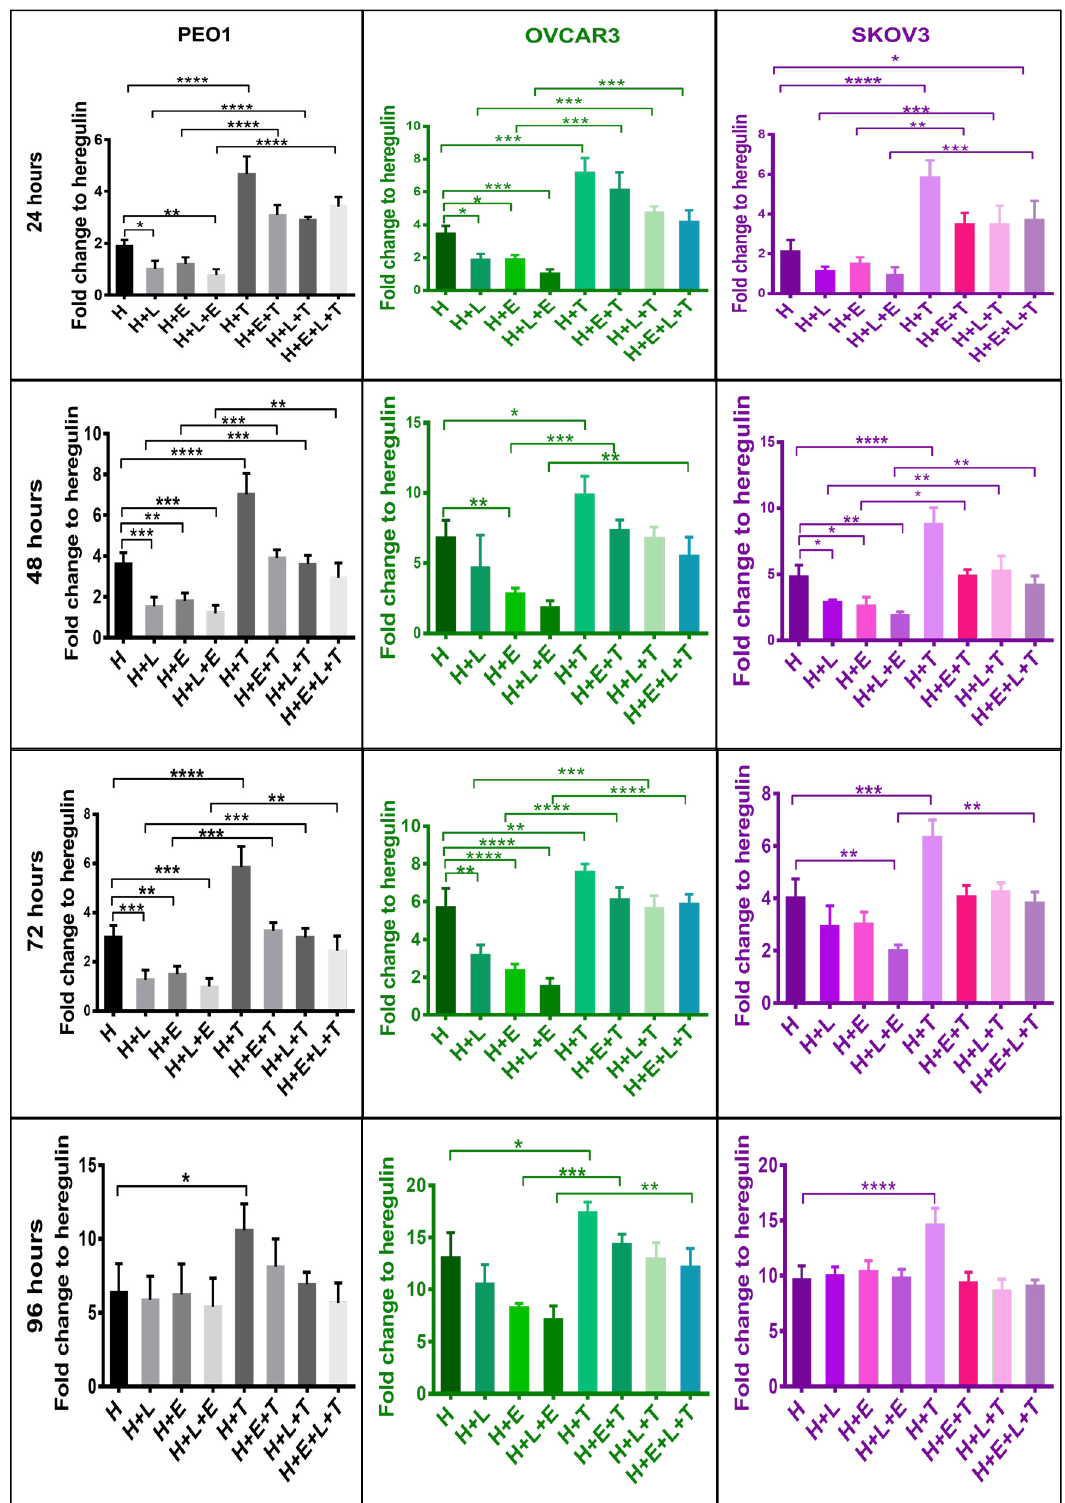
Figure 3. NRF2 activation confers cytoprotection against HER family targeting drugs, LAP (L) and ERL (E) in ovarian cancer cell lines. Cells were plated in media containing 1 nM H or treated with media containing 1 nM H and 5 μM of HER family kinase inhibitors: LAP (H + L), or ERL (H + E), or LAP and ERL (H + L + E), or 100 μM tBHQ (H + T), or tBHQ and LAP (H + L + T), or tBHQ and ERL (H + E + T) or combination of both inhibitors and tBHQ (H + E + L + T). tBHQ (100 µM) was added 5 h in advance and prior to treatments with inhibitors. Cell survival number was assessed indirectly and relative to control by use of the CellTiter-Glo assay (Promega). Values shown are means ± SD of triplicates adjusted relative to control. Statistical significance was calculated between H + L, H + T, and H + L + T groups by One-way ANOVA followed by Tukey’s post hoc test according to the scale (*: P < 0.05, **: P < 0.01, ***: P < 0.001, and ****: P <